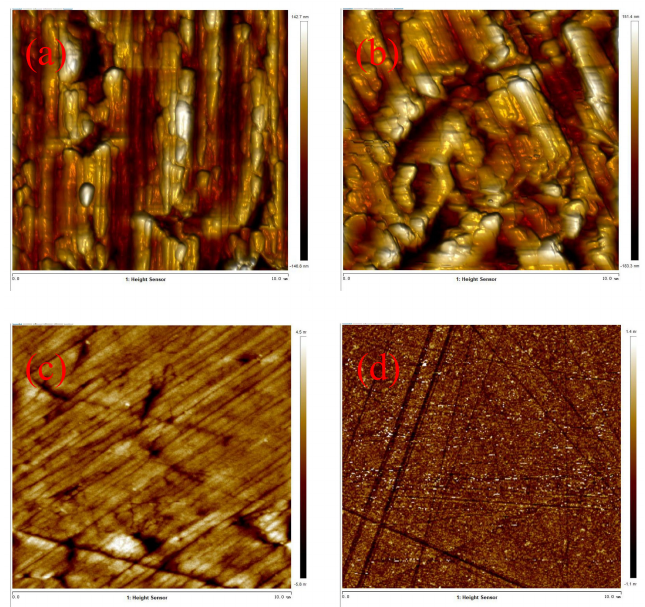
Figure 2. AFM of the surface of the samples after different process methods. ( a ) Sample 1 with the surface after wire cutting. ( b ) Sample 2 with surface after polishing. ( c ) Sample 3 with the surface after mechanical polishing. ( d ) Sample 4 with surface after chemical mechanical polishing.